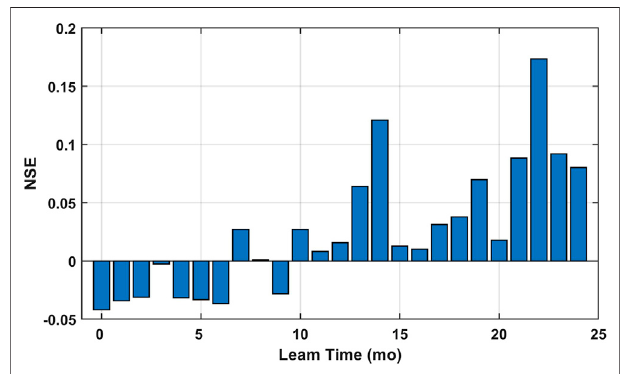
FIGURE 4 | Predictive skill for the testing set as a function of lead time reported in the NSE scores.